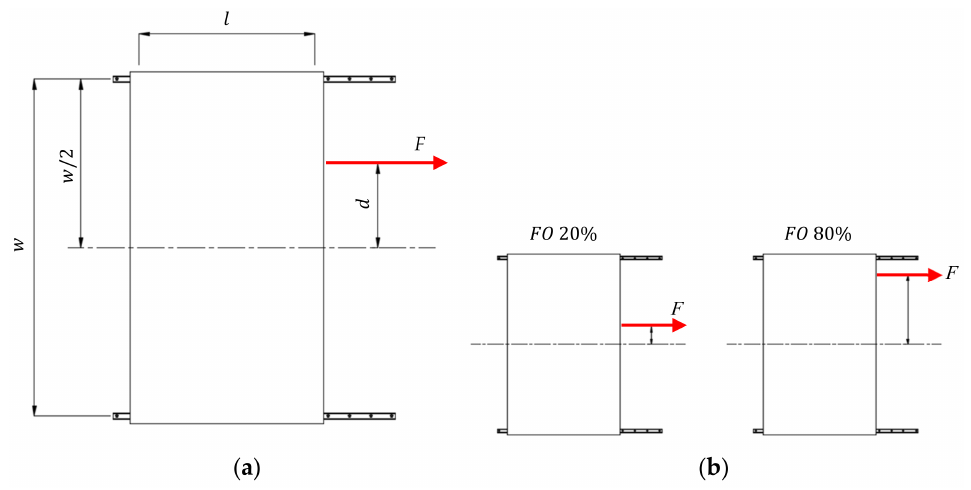
Figure 9. ( a ) Schematic diagram of FO definition and ( b ) comparison of FO 20% and FO 80%.